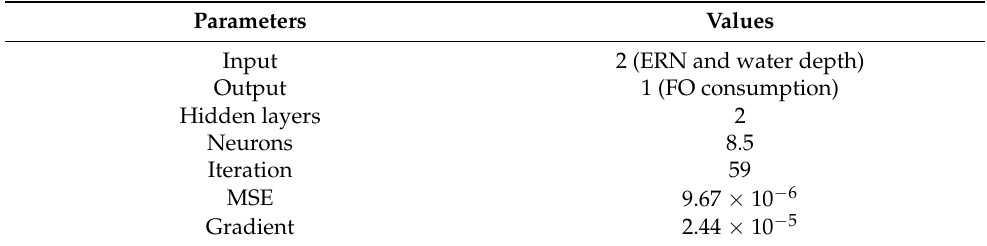
Table 4. Characteristics of the trained ANN for FO consumption in DP system. Parameters